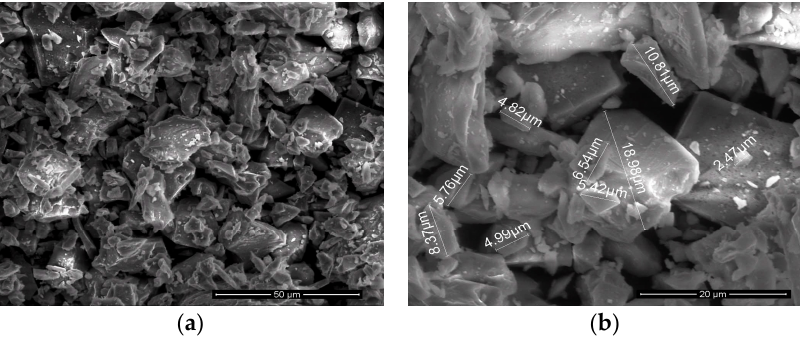
Figure 2. Samples assembled for the bond test and applied tensile load.